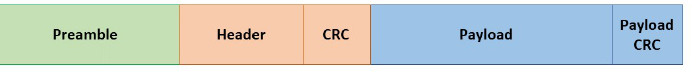
Figure 1. LoRa packet